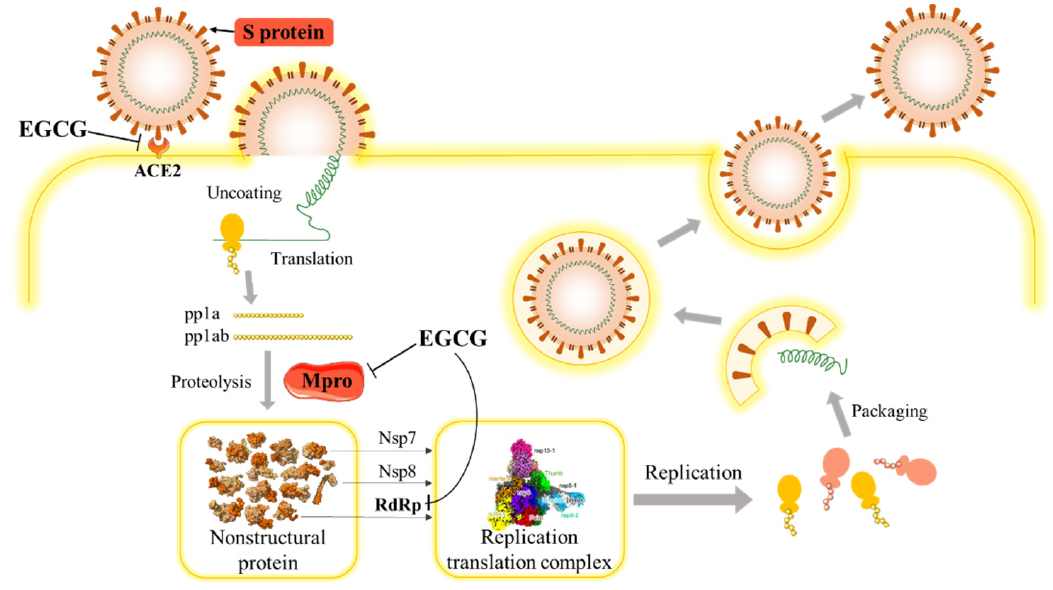
Figure 1. Schematic diagram of SARS-CoV-2 life cycle and the inhibition effects of EGCG.